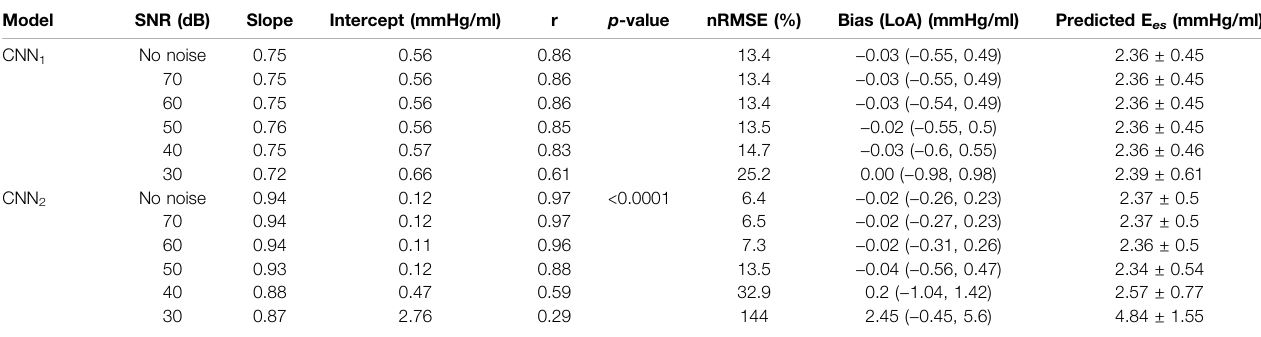
TABLE 5 | Regression statistics between model-predicted and reference elastance values.